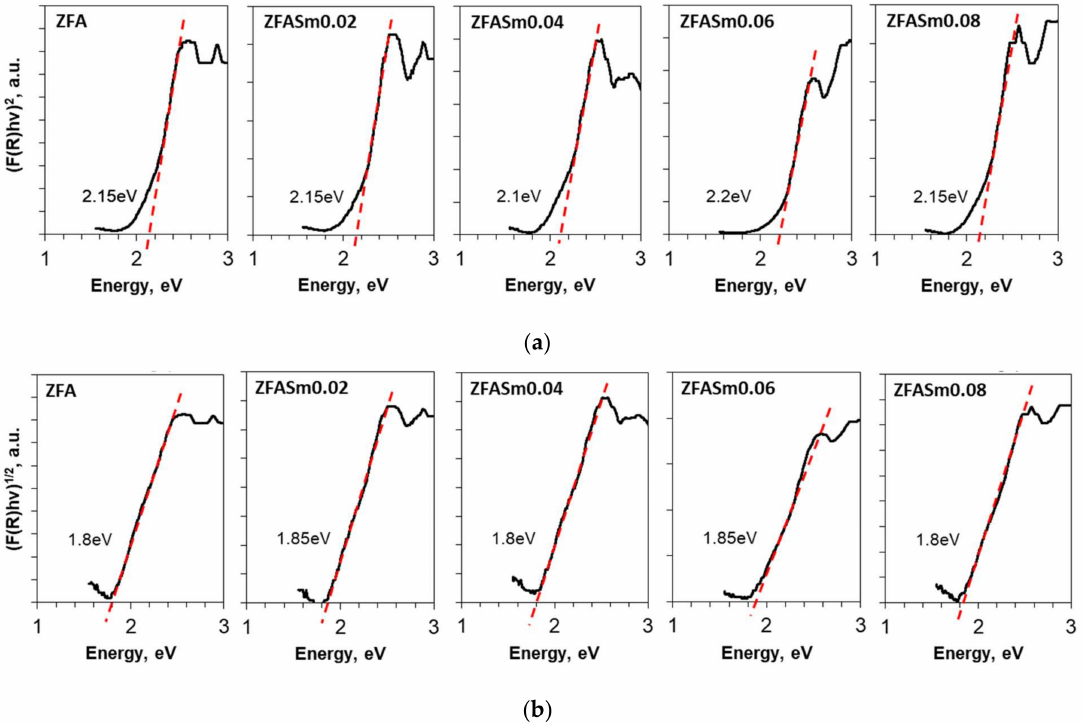
Figure 6. Direct band gap transition ( a ) and indirect band gap transition ( b ) in ZnAlFe 1 − x Sm x O 4 (x = 0, 0.02, 0.04, 0.06, 0.08)